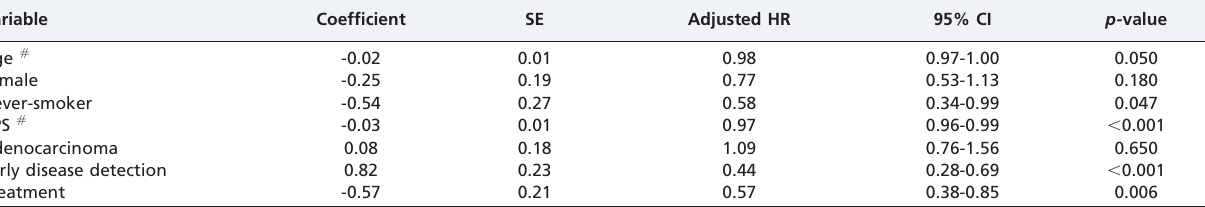
Table 3 - Multivariate analysis of factors related to overall survival in 285 NSCLC patients, using Cox regression (-2 log likelihood = 1,265.5; chi-squared= 60.0; p ,